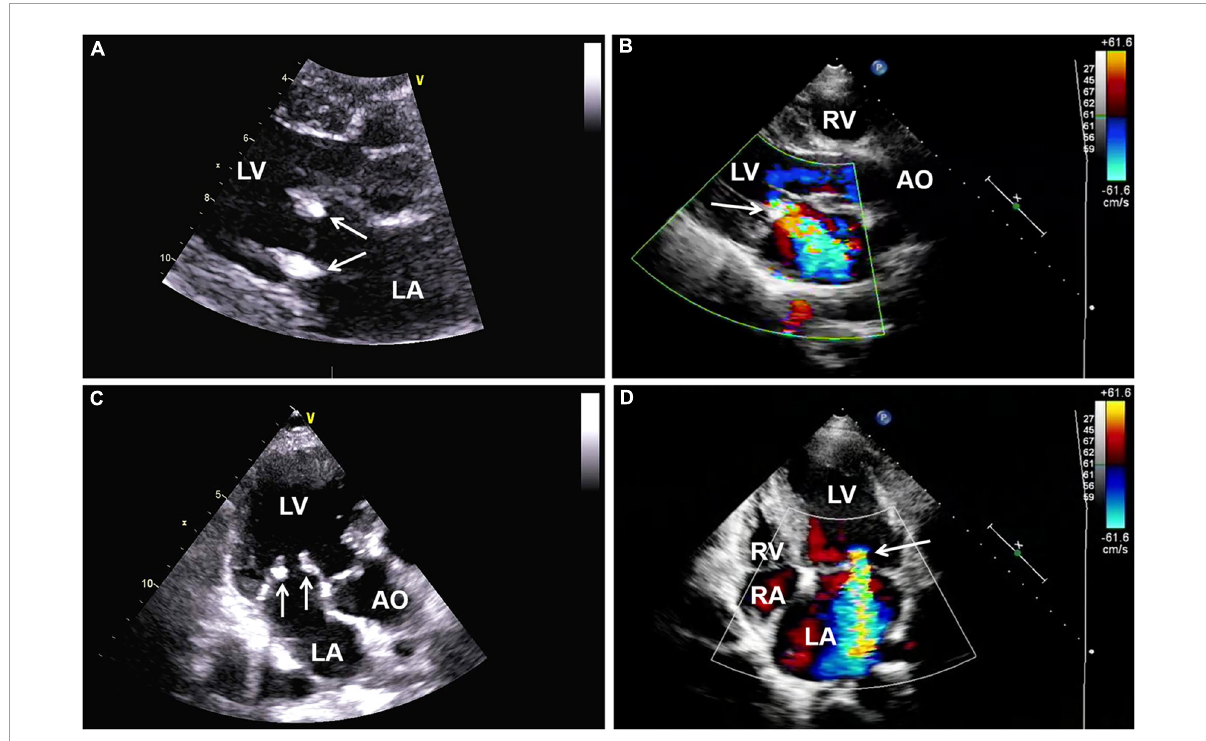
FIGURE3 (A,C) Follow-up transthoracic echocardiography (TTE) demonstrating thickening and hyperechoic lesions of mitral valve leaflets (arrows), suggesting valvular fibrosis. (B,D) Color Doppler imaging showing moderate to severe regurgitation of the mitral valve. AO, aorta; LA, left atrium; LV, left ventricle; RA, right atrium; RV, right ventricle; TTE, transthoracic echocardiography.